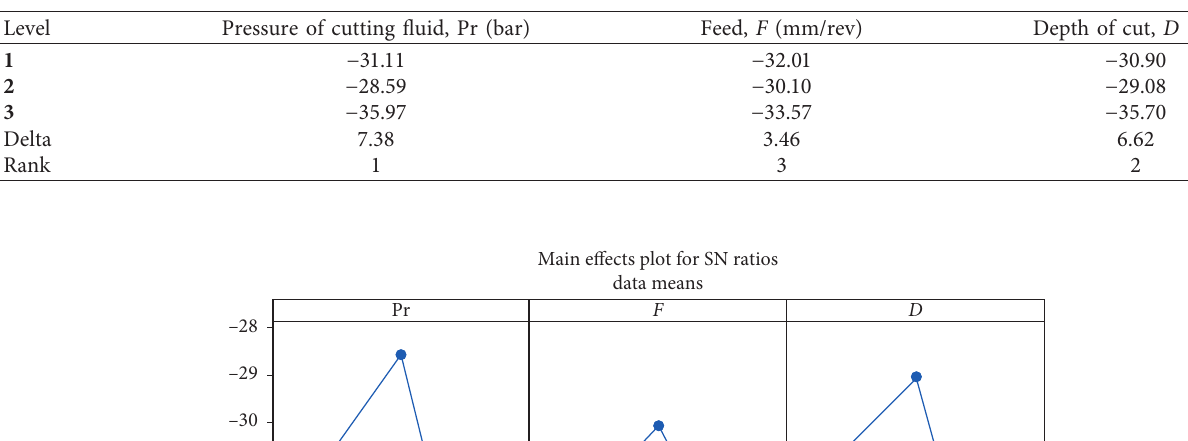
Table 6: Thrust force-based response ratios of signal to